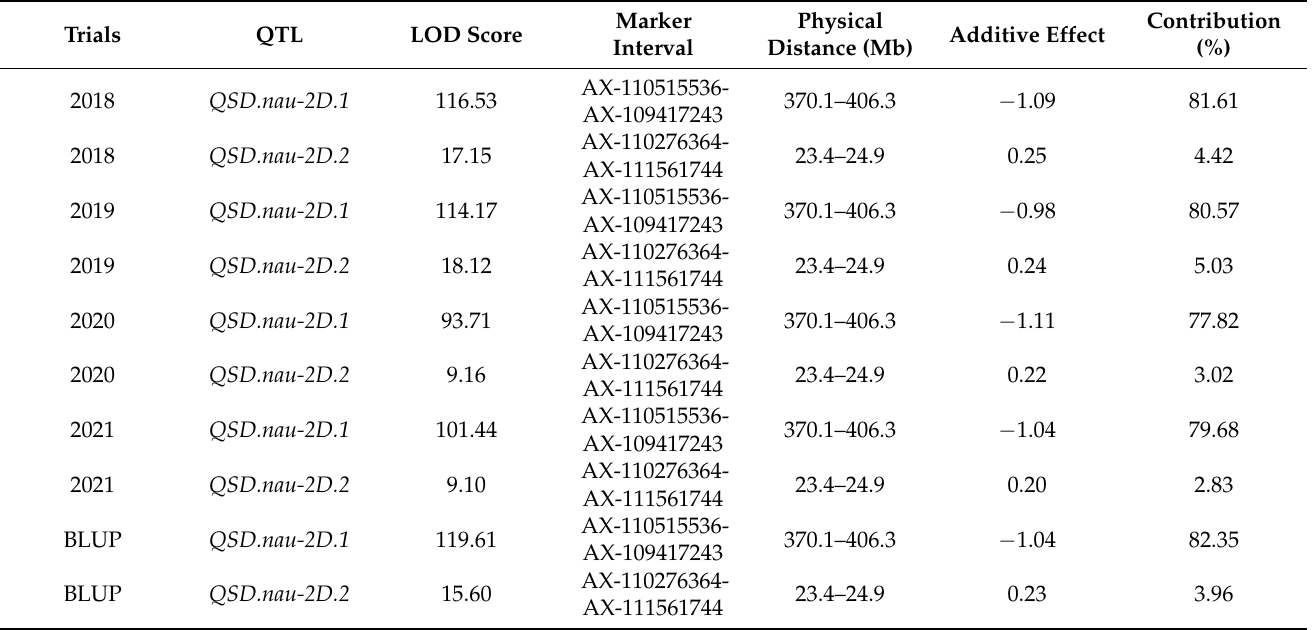
Table 2. Summary of QTL on chromosome 2D for spike density trait from four environments during years 2018–2021 and their BLUP values in the RIL